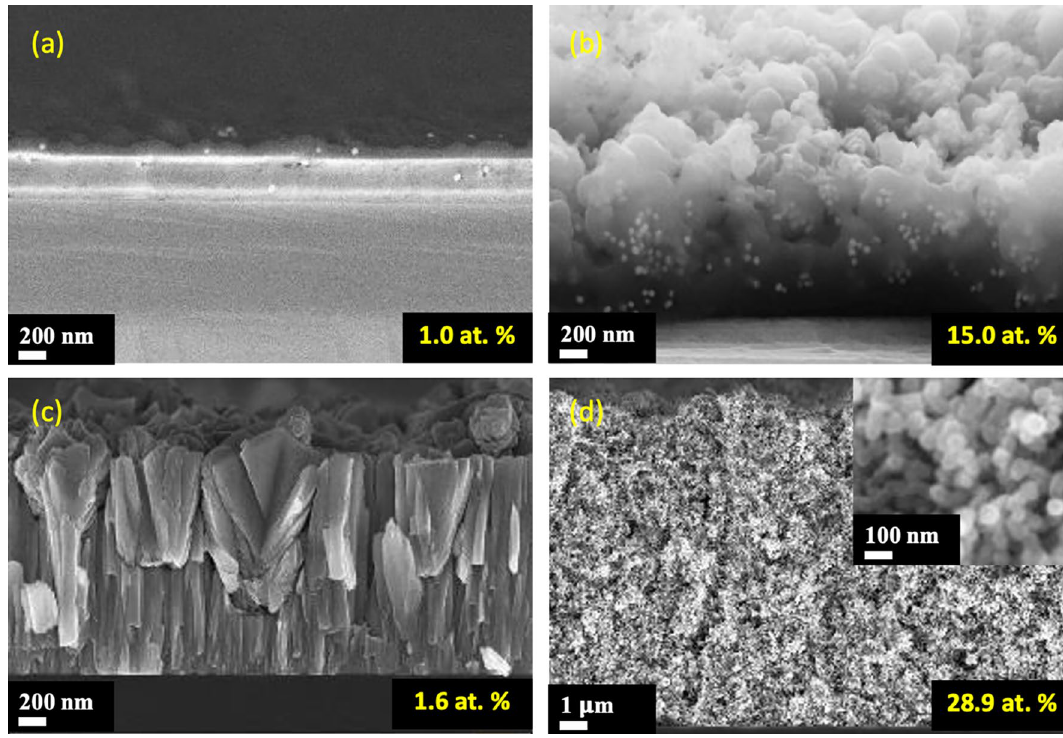
Figure 3. Metallic nanoparticles in a ceramic matrix (Au-np in SiO 2 matrix) with 1 at.% np ( a ) and 15 at.% np ( b ); ceramic nanoparticles in a metallic matrix (Si-np in Cr matrix) with 1.6 at.% np ( c ) and 28.9 at.% np ( d ).